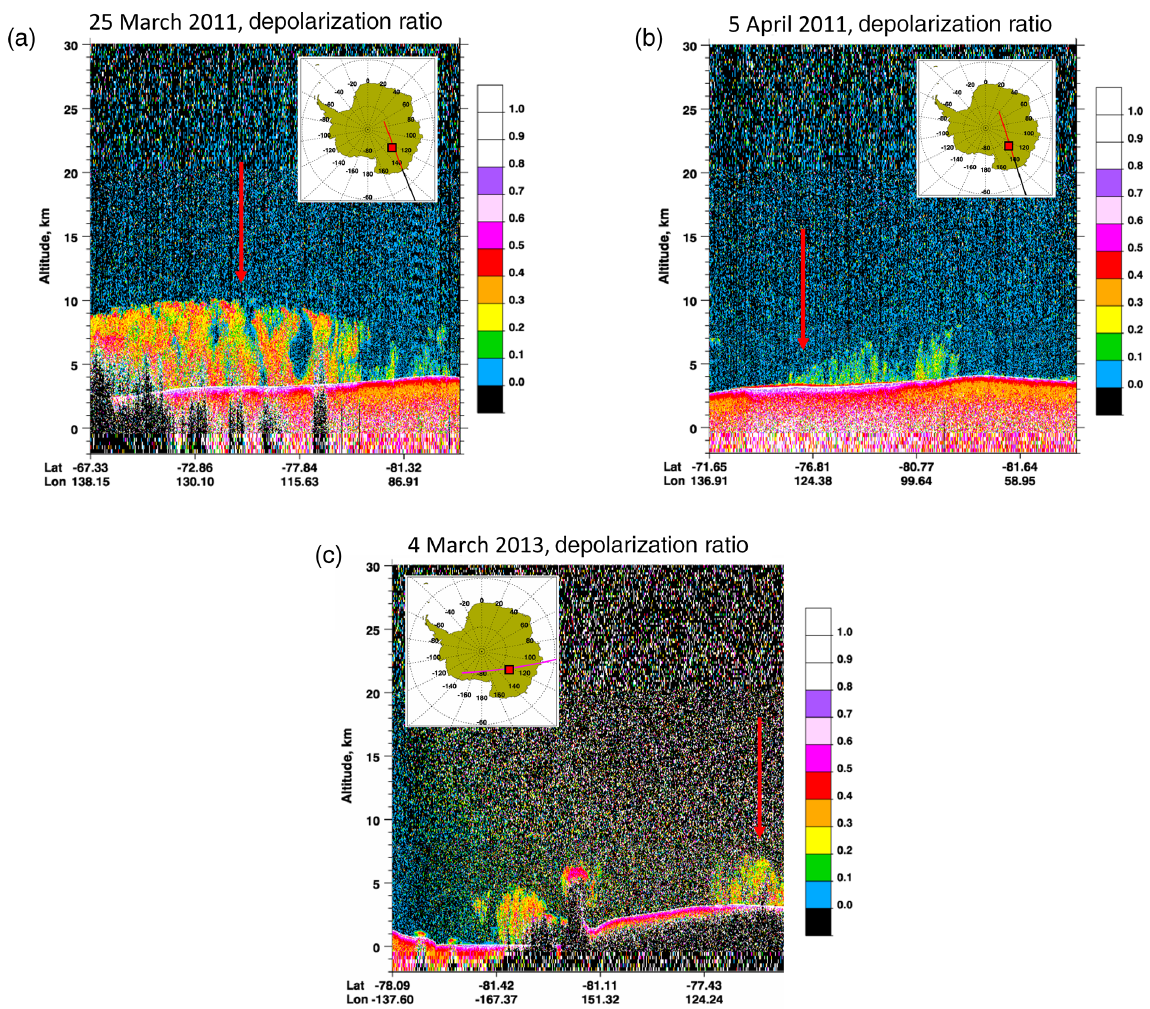
Figure 2. Space-borne lidar CALIOP measurements of depolarization ratio along one orbit in the vicinity of the Dome C station on 25 March 2011 (a) , 5 April 2011 (b) and 4 March 2013 (c) . The red square represents the location of the Dome C station. The red vertical arrow represents the approximate location of the Dome C